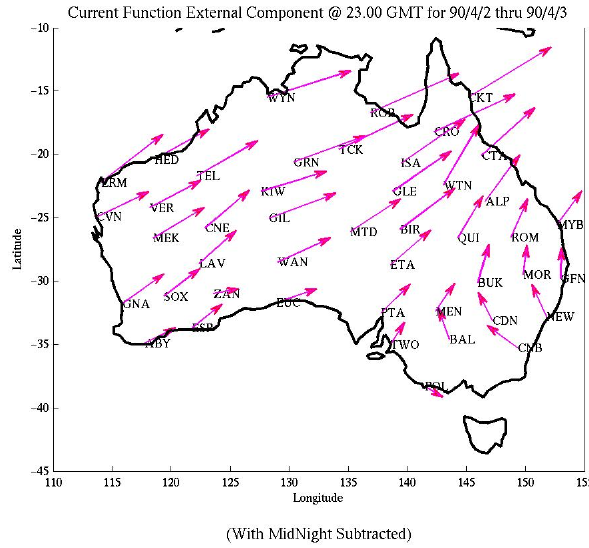
Fig. 5. As for Fig. 1 but for 23:00 UT on 2 April 1990. Arrow lengths: 5 ◦ longitude length is equivalent to 30nT.